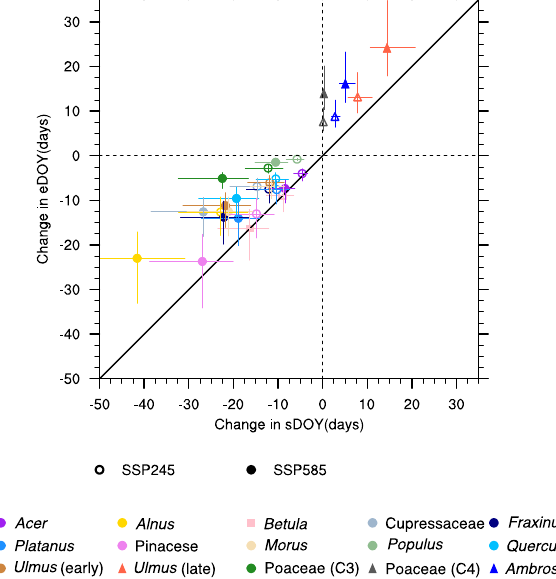
Fig. 1 Future change in pollen season start date and end date. The projected change of start day of year (sDOY) and end day of year (eDOY) of pollen season at the end of century (2081 – 2100) for individual taxa. Each symbol represents the multi-model mean of the spatially and temporally averaged 15 model members. Error bars represent the minimum and maximum from the 15 CMIP6 (Coupled Model Intercomparison Project Phase 6) model ensembles ( n = 15). Open (Shared Socioeconomic Pathway (SSP) 245) and closed (SSP 585) symbols indicate the results from different future emissions scenarios. Circles represent the taxa in Category 1, squares in Category 2, and triangles in Category 3 (visualized in Fig. 1). 1:1 reference in provided with the solid black line. Source data are provided as source data fi